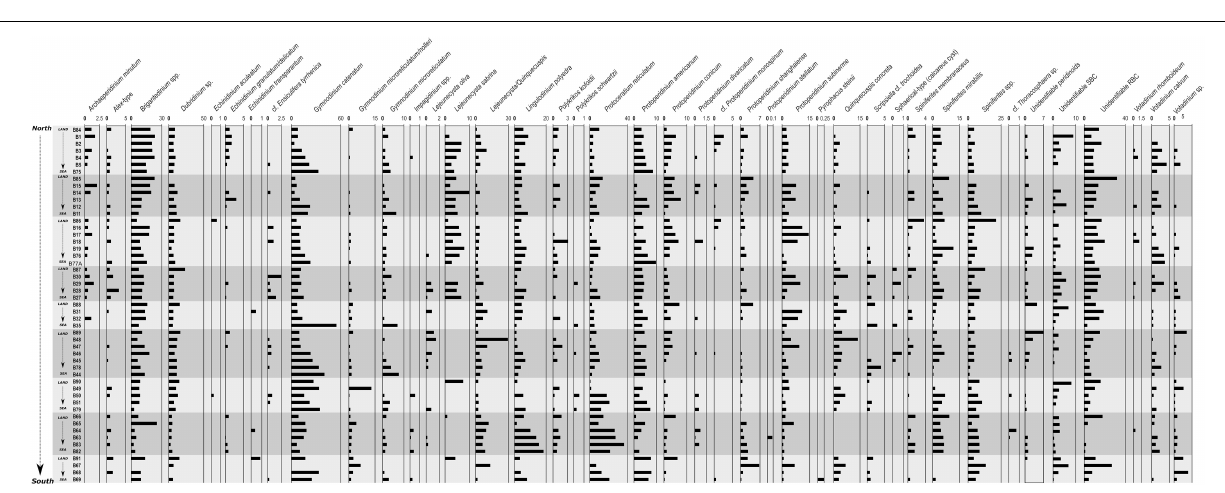
FIGURE 6 | Dinoflagellate cyst percentages obtained for the studied 51 surface samples. Samples are arranged by nine transects perpendicular to the coast, from north to south (top to bottom). Those cyst types for which identification was doubtful were summed to a higher category, i.e ., Brigantedinium spp. includes Brigantedinium sp. and cysts of Protoperidinium avellana and P. cariacoense ; Dubridinium spp. includes Dubridinium sp. and D. caperatum ; Impagidinium spp. includes Impagidinium sp., I. paradoxum , and I. aculeatum ; Spiniferites spp. includes Spiniferites sp., S. bentorii , and S. delicatus ; RBC includes unidentifiable round browns and cf. Diplopsalis